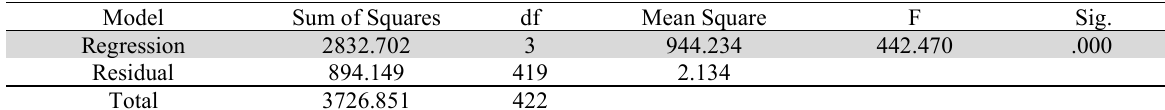
The results of ANOVA test